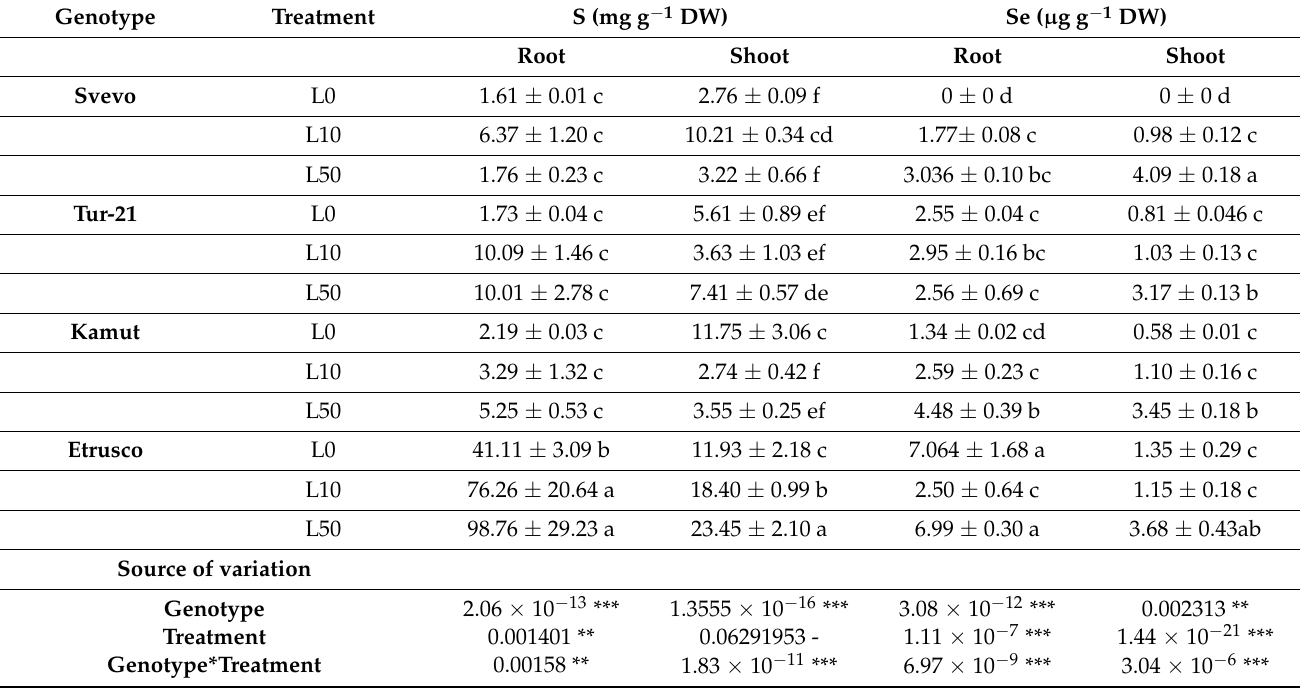
Table 2. Root and shoot sulfur and selenium concentrations of four wheat genotypes (Svevo, Tur-21, Kamut, and Etrusco) grown under limited (L) availability of